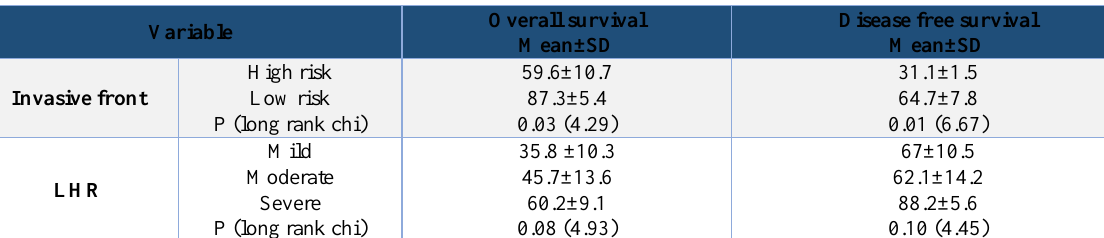
Table 4. Evaluation of overall survival and disease free survival on invasive front and lymphocytic host response (LHR)